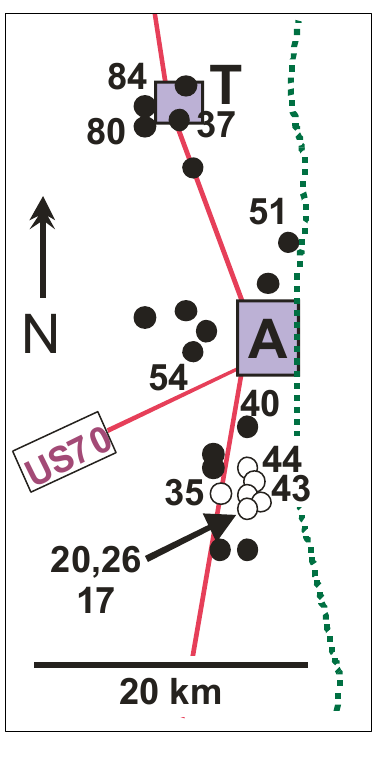
Figure 6. Detail of Figure 3, showing distribution of carbon-14 (pMC) in groundwater samples. Black circles: this study; white circles: data from